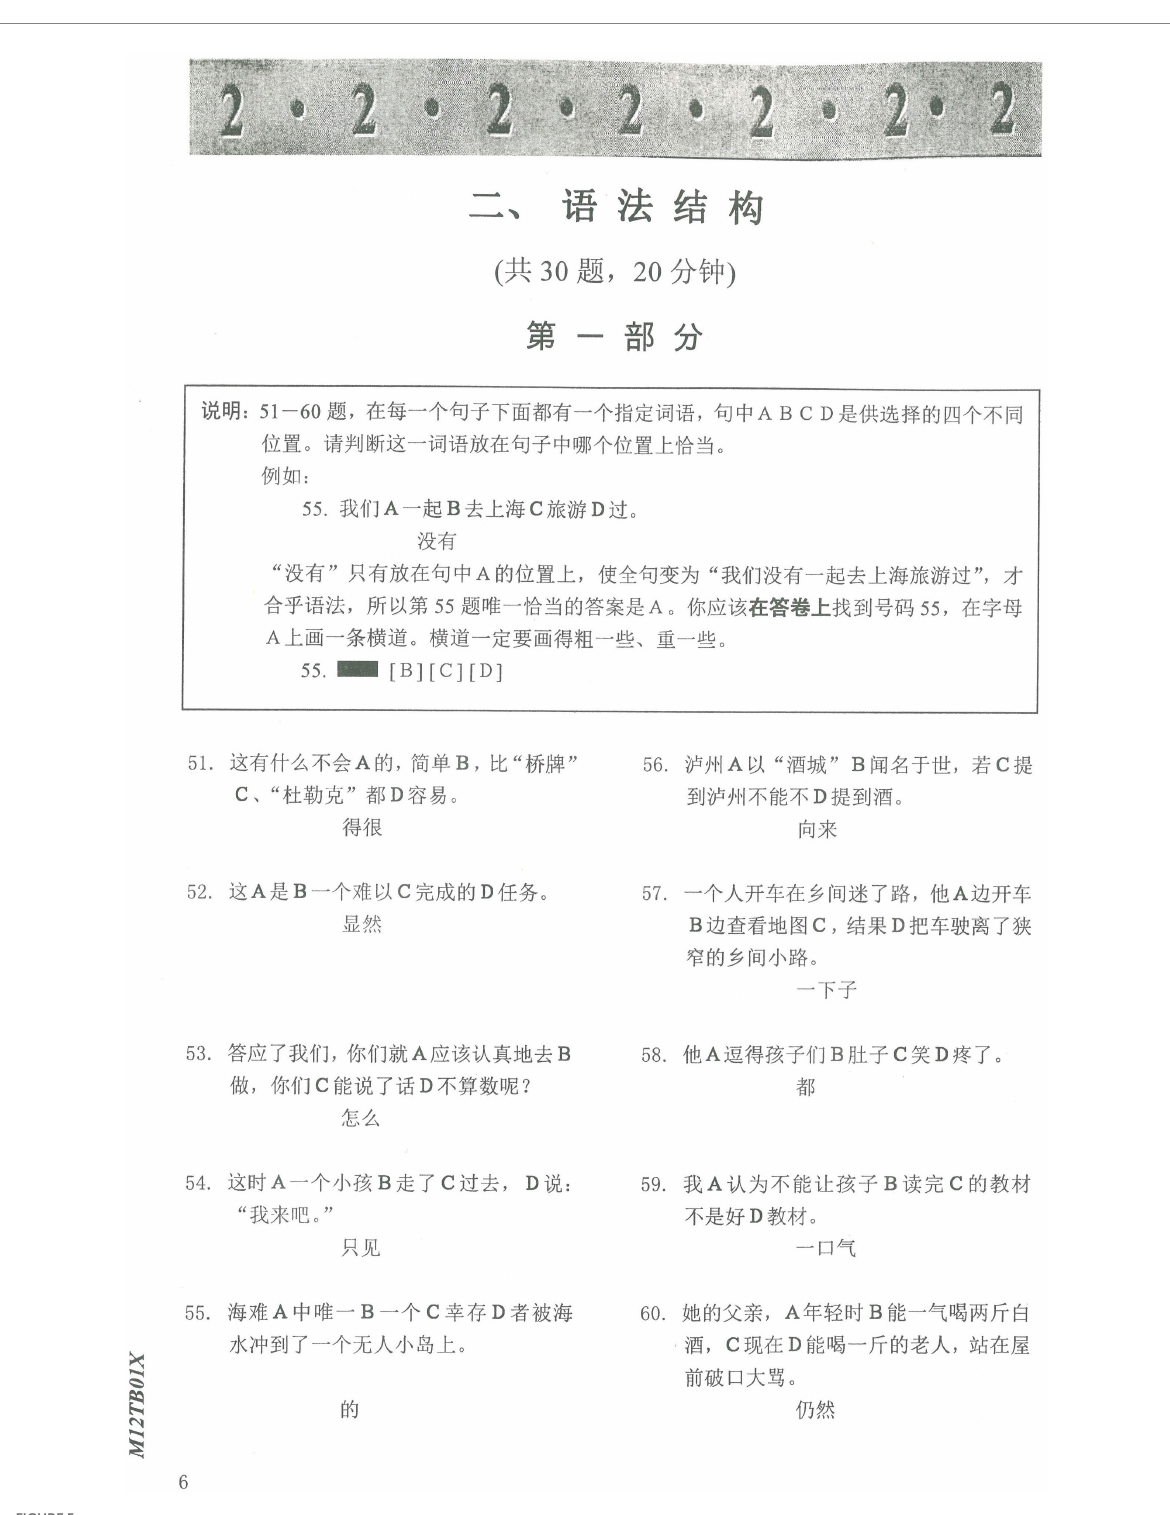
FIGURE 5 Sample test in the HSK vocabulary